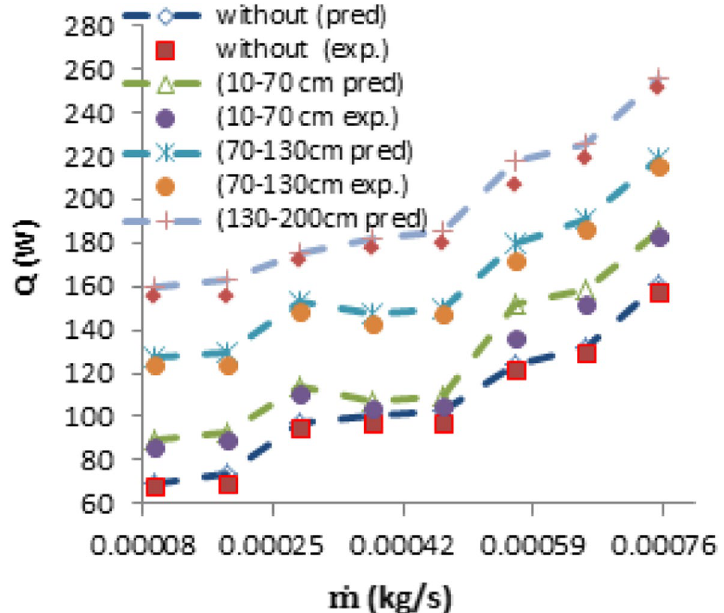
Fig. 10 ANN predicted and experimental heat transfer with and without